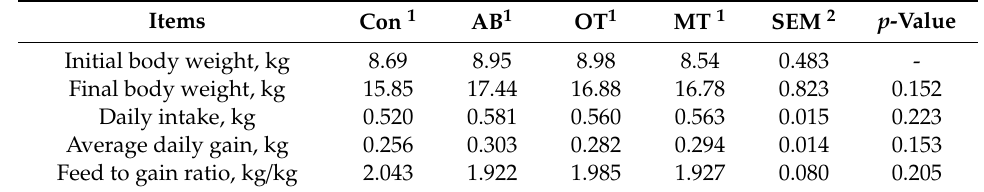
Table 2. E ff ect of dietary supplementation with tributyrin in combination with di ff erent essential oils on growth performance of weaned pigs.